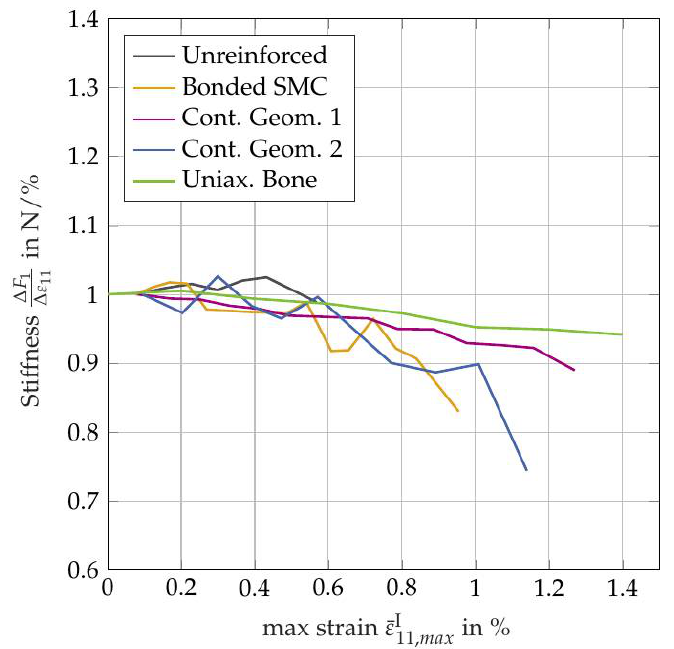
Figure 1. Stiffness over the maximum strain reached in the area of interest over the whole loading history until the instant of the